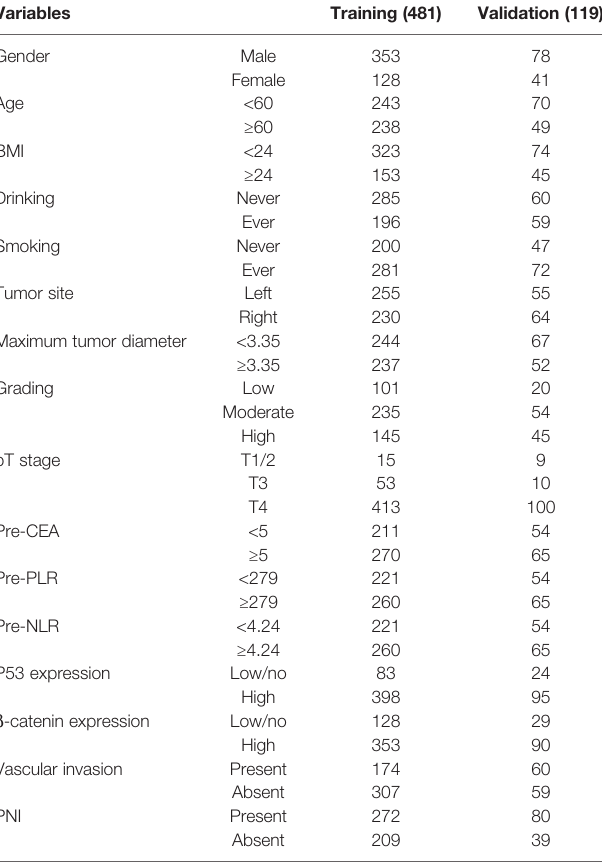
TABLE 1 | Clinicopathological characteristics of colon cancer patients in two data sets. Variables